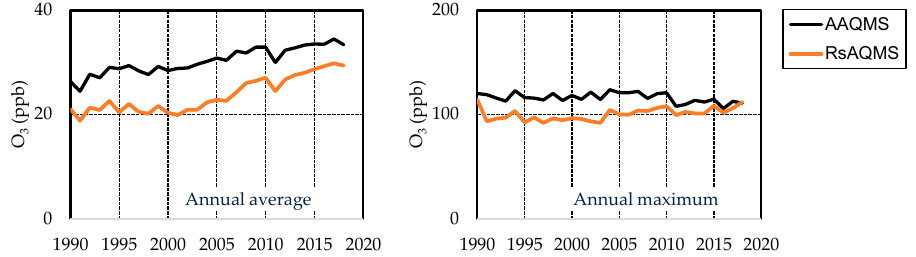
Figure 5. Annual average of 1-h daytime and annual maximum ozone concentrations at the AAQMS and RsAQMS of the nation and each region from 1990 to 2018.